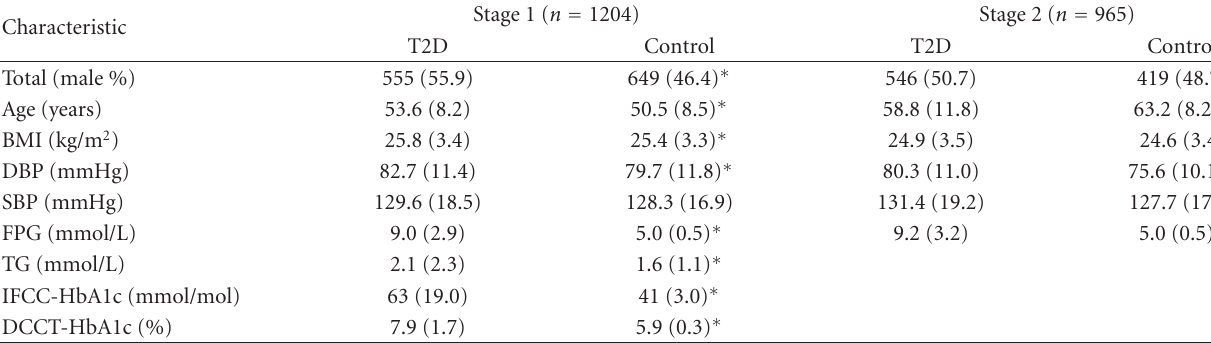
Table 1: Characteristics of the study populations.